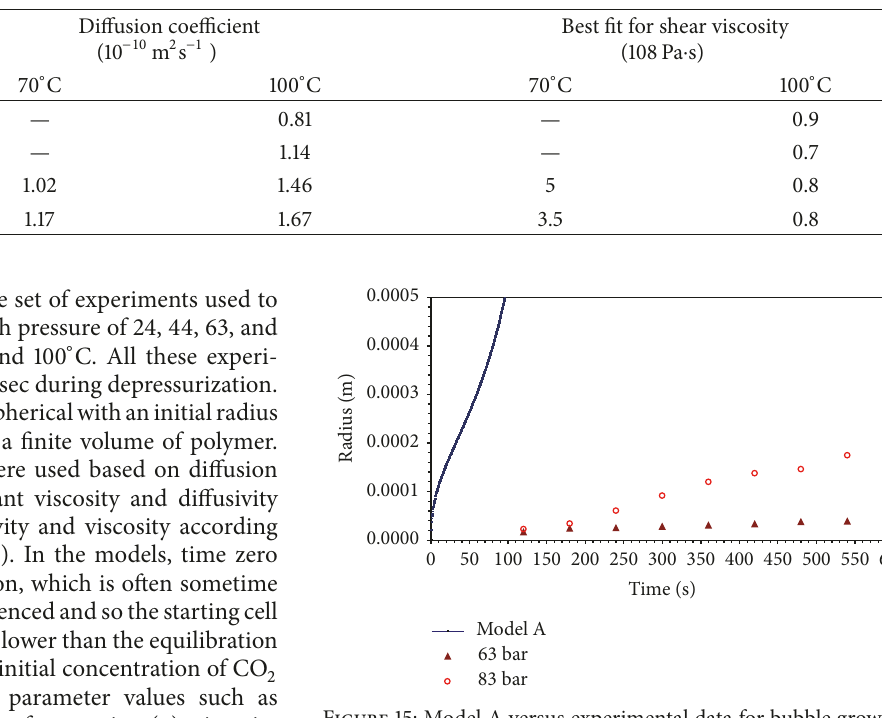
Table 2: Model B best fit for shear viscosity values and diffusivity values [19].